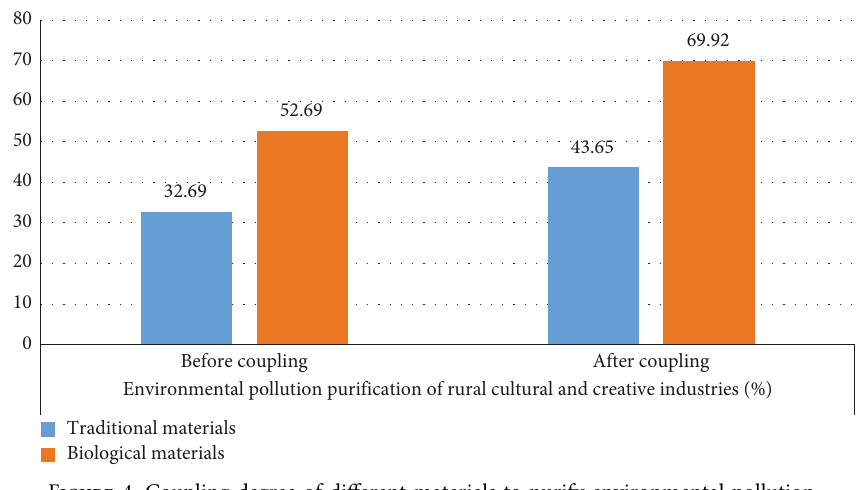
Figure 4: Coupling degree of different materials to purify environmental